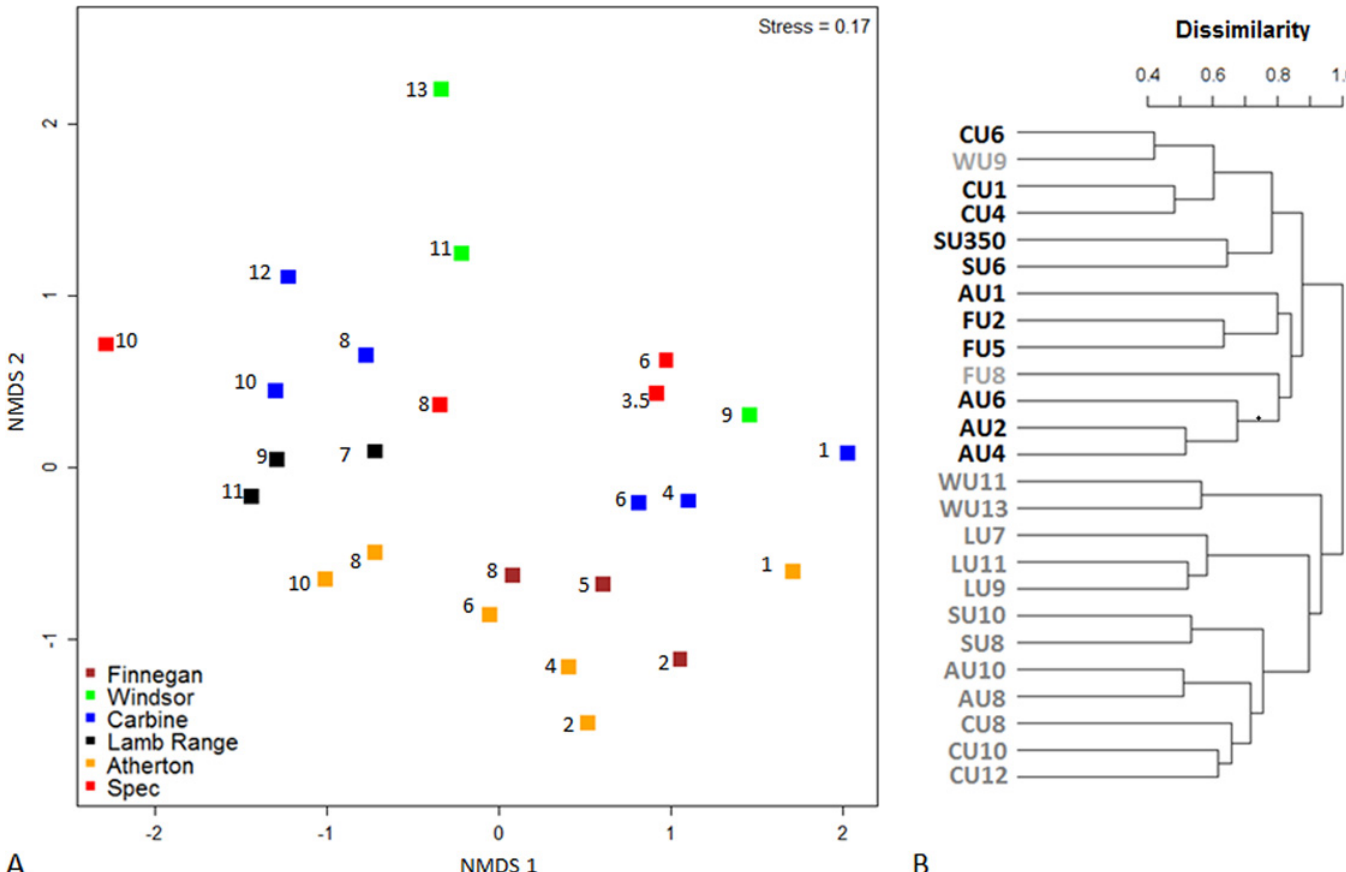
Fig 6. (A) NMDS of ant community composition captured from all 26 sites, based on species frequency data from 2011/12 wet season samples. Numbers next to each point represent elevation ( ‘ 00 m a.s.l.). ( B) Cluster dendrogram based on dissimilarity in species composition, using the same data; sites at 600 m or lower elevation are shown in